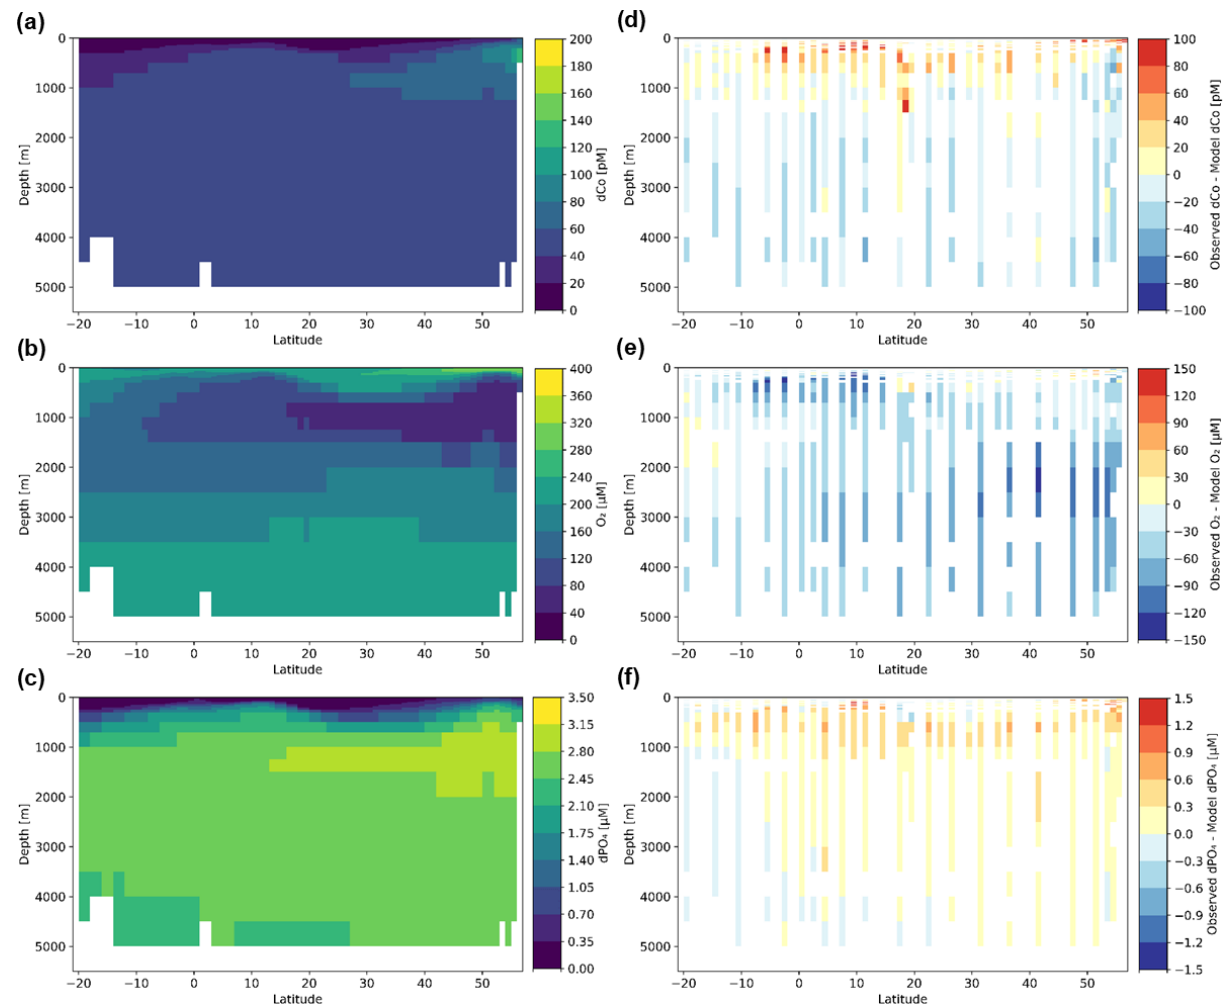
Figure 16. (a–c) Model output of dCo, O 2 and dPO 4 distributions along the GP15 transect. (d–f) Differences between observed values and model outputs of dCo, O 2 and dPO 4 concentrations along the GP15 transect. Observed values have been binned and averaged by 1 ◦ latitude and 31 depth divisions to ensure comparability between the model and sample values. Note that O 2 values are reported here in units of